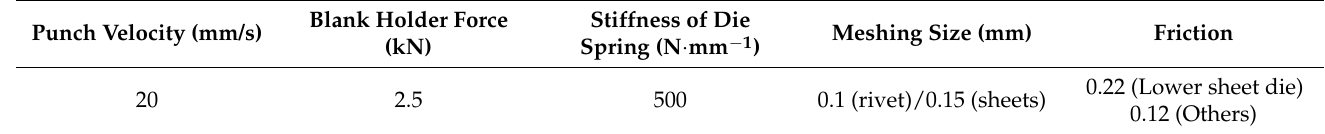
Table 3. Parameters in the finite element